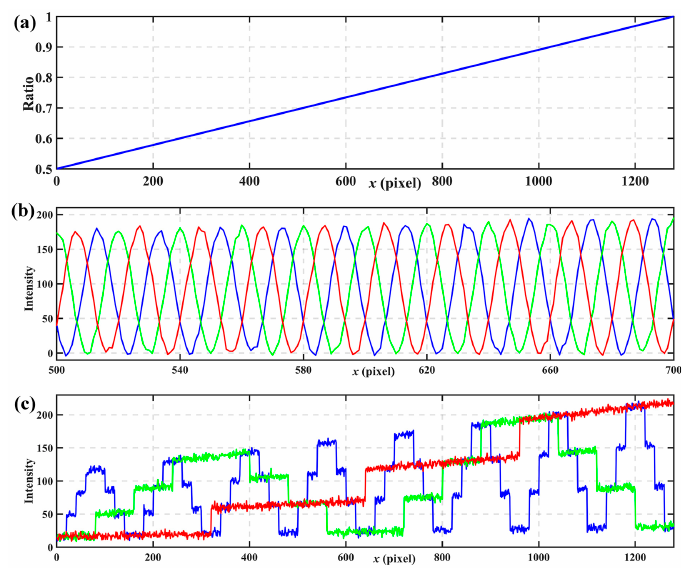
Figure 5. Simulated patterns. ( a ) modulation function, ( b ) modulated phase-shift patterns with noises, ( c ) modulated coded patterns with noises.